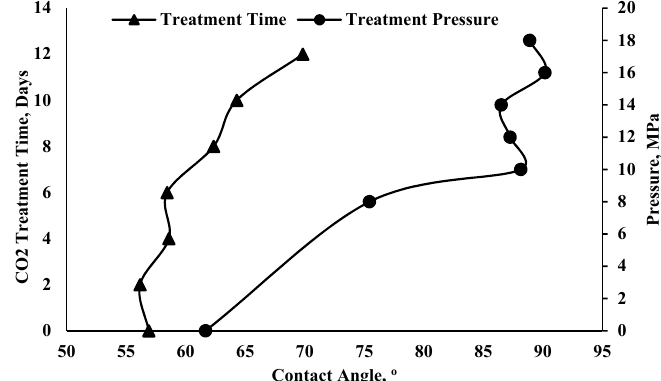
Figure 7. The changes in contact angle associated with SCCO 2 treatment time and pressure [52]. Table 3. Summary of related work on the effect of CO 2 injection on wettability and contact angle.